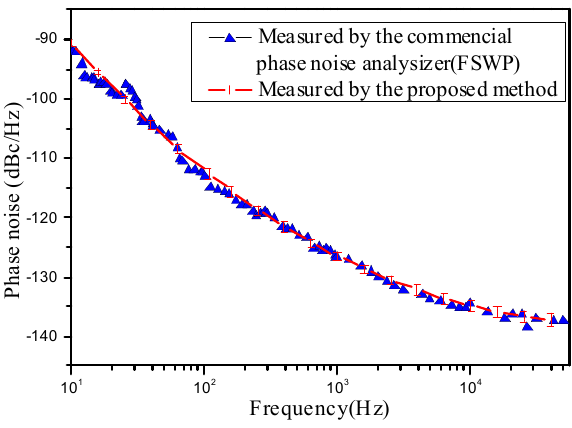
Figure 3. Comparison between fitting and model restoring (600 MHz).